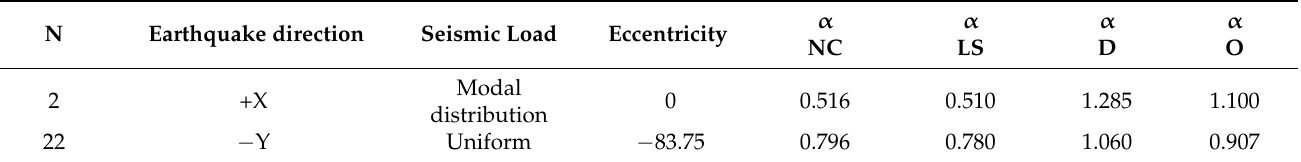
Table 3. Results of worst pushover analyses on the bare building.